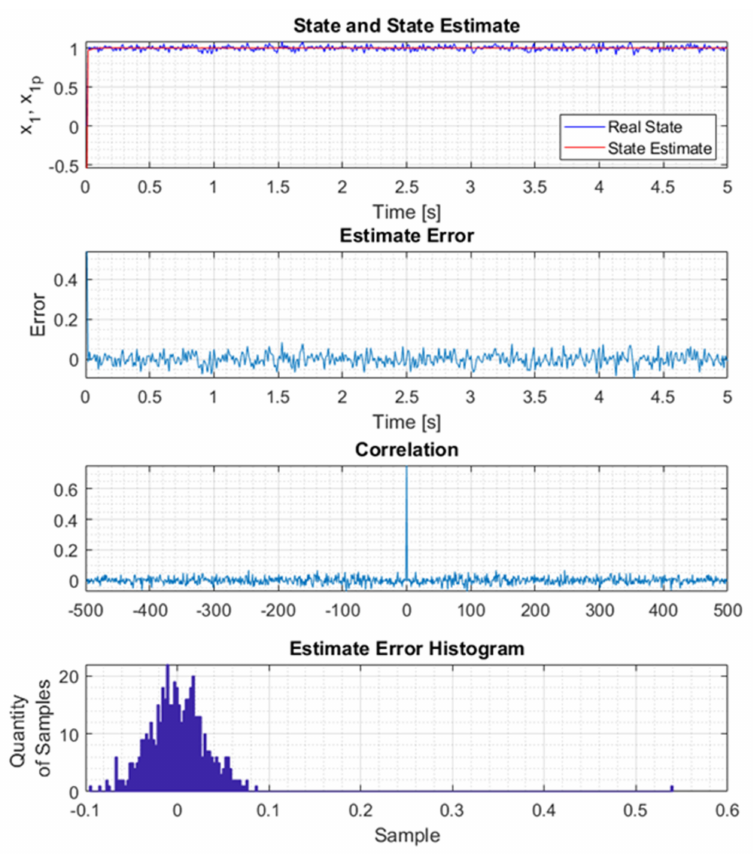
Figure 17. The course of the system state and its estimation for the calculated gain.